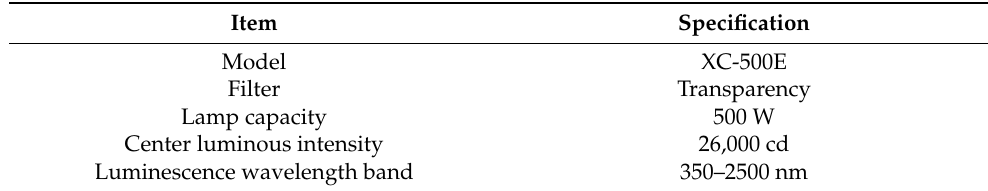
Figure 1. Schematics of experimental room. PPG: photo-plethysmography; EGG: electroencephalo- gram; HVAC: heating, ventilating, and air-conditioning. Table 1. Specification of solar lighting device.